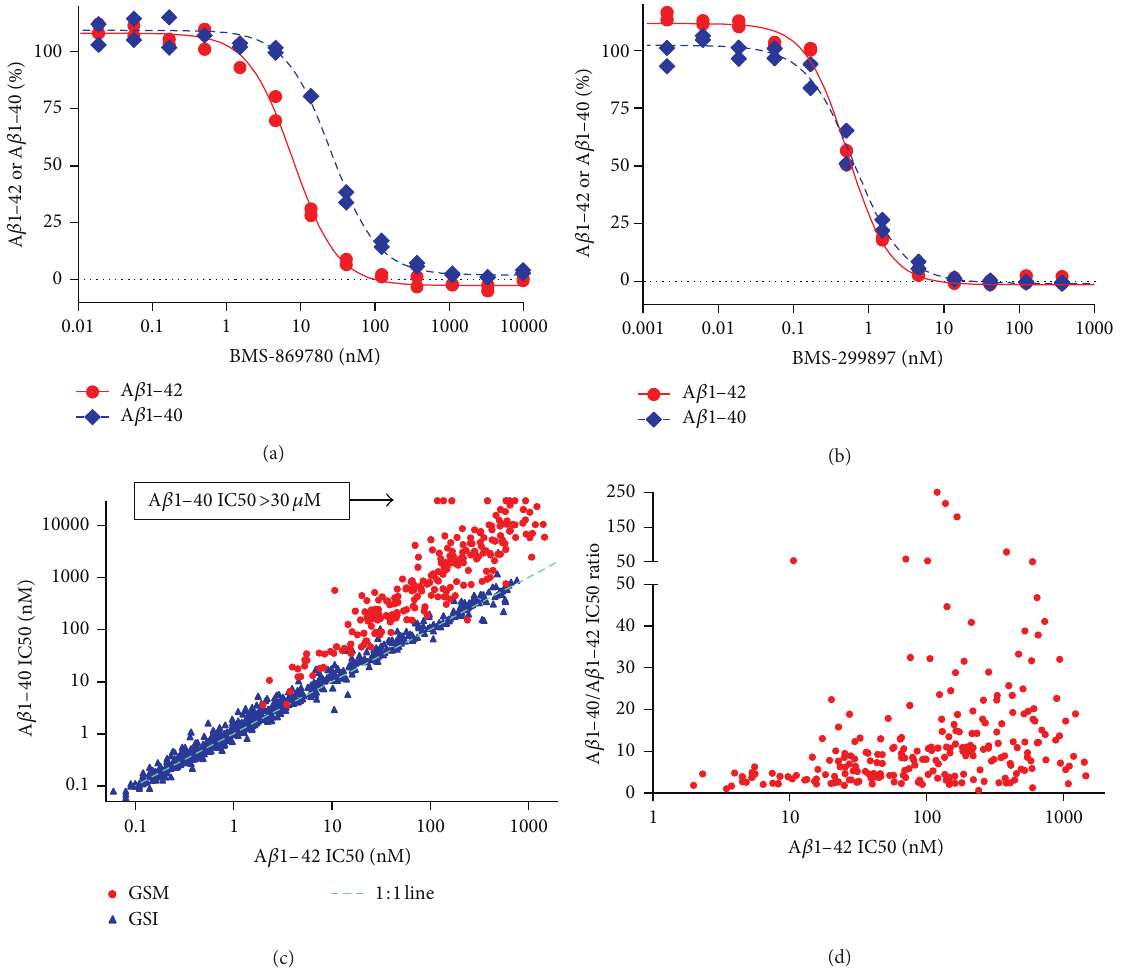
Figure 2: In vitro potency of BMS-869780 in the HTS assay. (a) H4-APPsw cultures were treated overnight with BMS-869780 (a GSM) at a range of concentrations and the relative levels of A 𝛽 1-42 (red e ) and A 𝛽 1-40 (blue Q ) were determined for calculation of IC 50 values (summarized in Table 1). (b) H4-APPsw cultures were treated overnight with BMS-299897 (a representative GSI) as described for BMS- 869780 in panel (a). IC 50 values are summarized in Table 1. (c) IC 50 values for A 𝛽 1-42 and A 𝛽 1-40 lowering were determined for 236 GSM (red e ) and for 688 GSI that were mostly of the type containing the aryl sulfonamide core (blue 󳵳 ). For some compounds, the A 𝛽 1-40 IC 50 value was greater than 30 𝜇 M, the highest concentration tested in the A 𝛽 1-40 assay (arrow). (d) The ratio of the A 𝛽 1-40 IC 50 to A 𝛽 1-42 IC 50 was plotted against A 𝛽 1-42 IC 50 for the same 236 GSM illustrated in